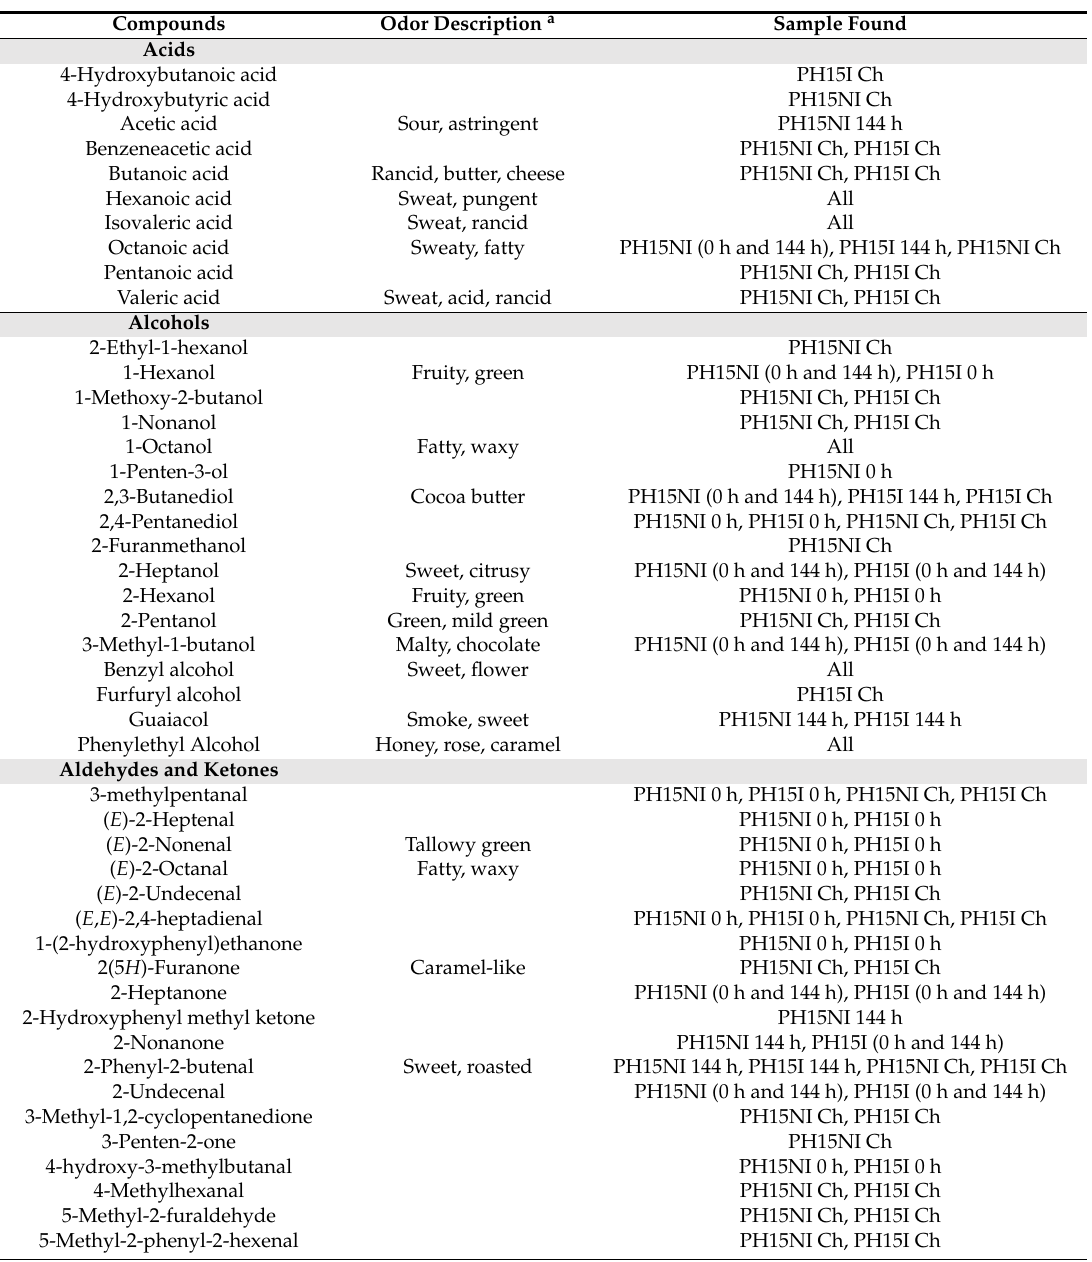
Volatile compounds identified by Headspace—Solid Phase Microextraction—Gas Chromatography Mass Spectrometry (HS–SPME GC–MS) during fermentation times (0 h and 144 h) and in chocolate samples, and the reference odor of each